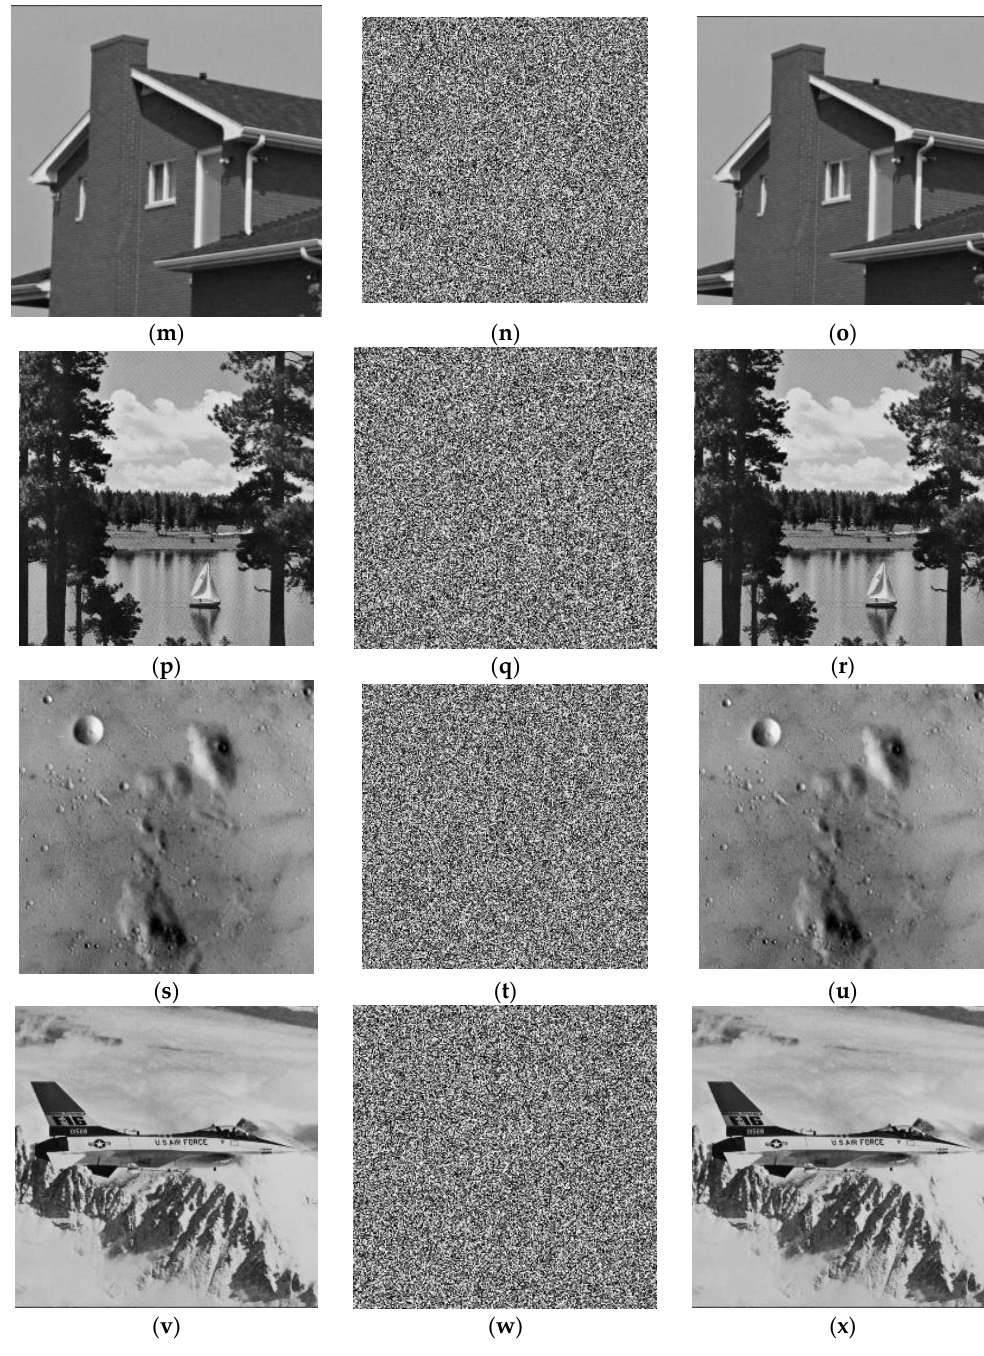
Figure 6. Simulation results of four gray images. ( a ) plaintext image of Lena; ( b ) the amplitude of encrypted image of Lena; ( c ) decrypted image of Lena; ( d ) plaintext image of Boat; ( e ) the amplitude of encrypted image of Boat; ( f ) decrypted image of Boat; ( g ) plaintext image of Cameraman; ( h ) the amplitude of encrypted image of Cameraman; ( i ) decrypted image of Cameraman; ( j ) plaintext im- age of Pepper; ( k ) the amplitude of encrypted image of Pepper; ( l ) decrypted image of Pepper; ( m ) plaintext image of House; ( n ) the amplitude of encrypted image of House; ( o ) decrypted image of House; ( p ) plaintext image of Lake; ( q ) the amplitude of encrypted image of Lake; ( r ) decrypted image of Lake; ( s ) plaintext image of Moon surface; ( t ) the amplitude of encrypted image of Moon surface; ( u ) decrypted image of Moon surface; ( v ) plaintext image of Plane; ( w ) the amplitude of encrypted image of Plane; ( x ) decrypted image of Plane.